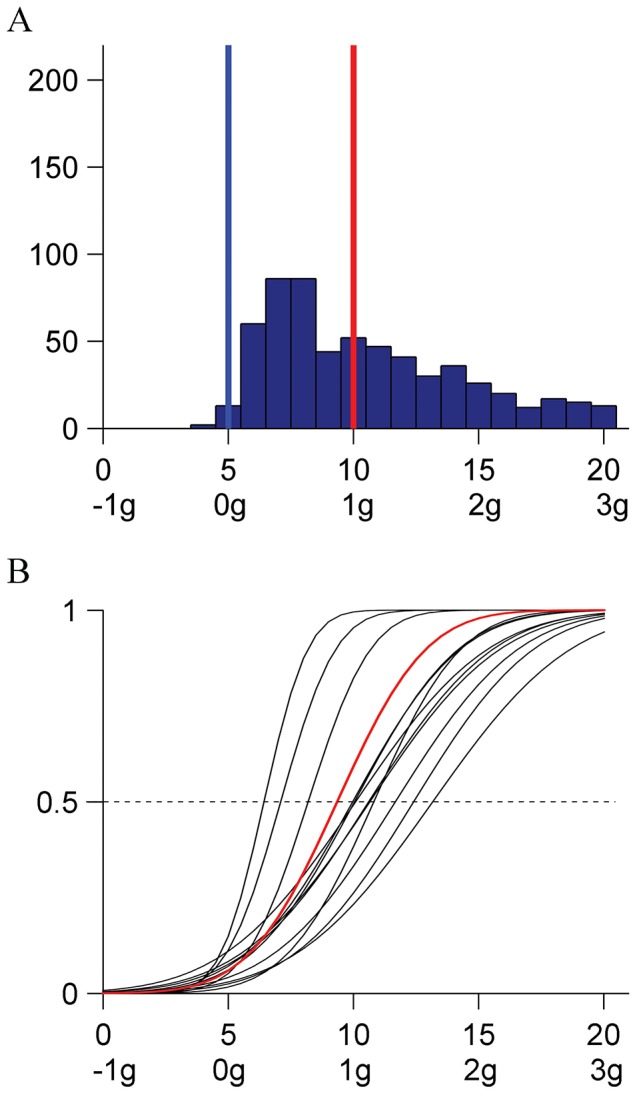
Experiment 2 (0° orientation, unidirectional).A: Distribution histogram of the responses (pooled over participants). B: CDFs for each participant and for the population. Same format as in Figure 2B.